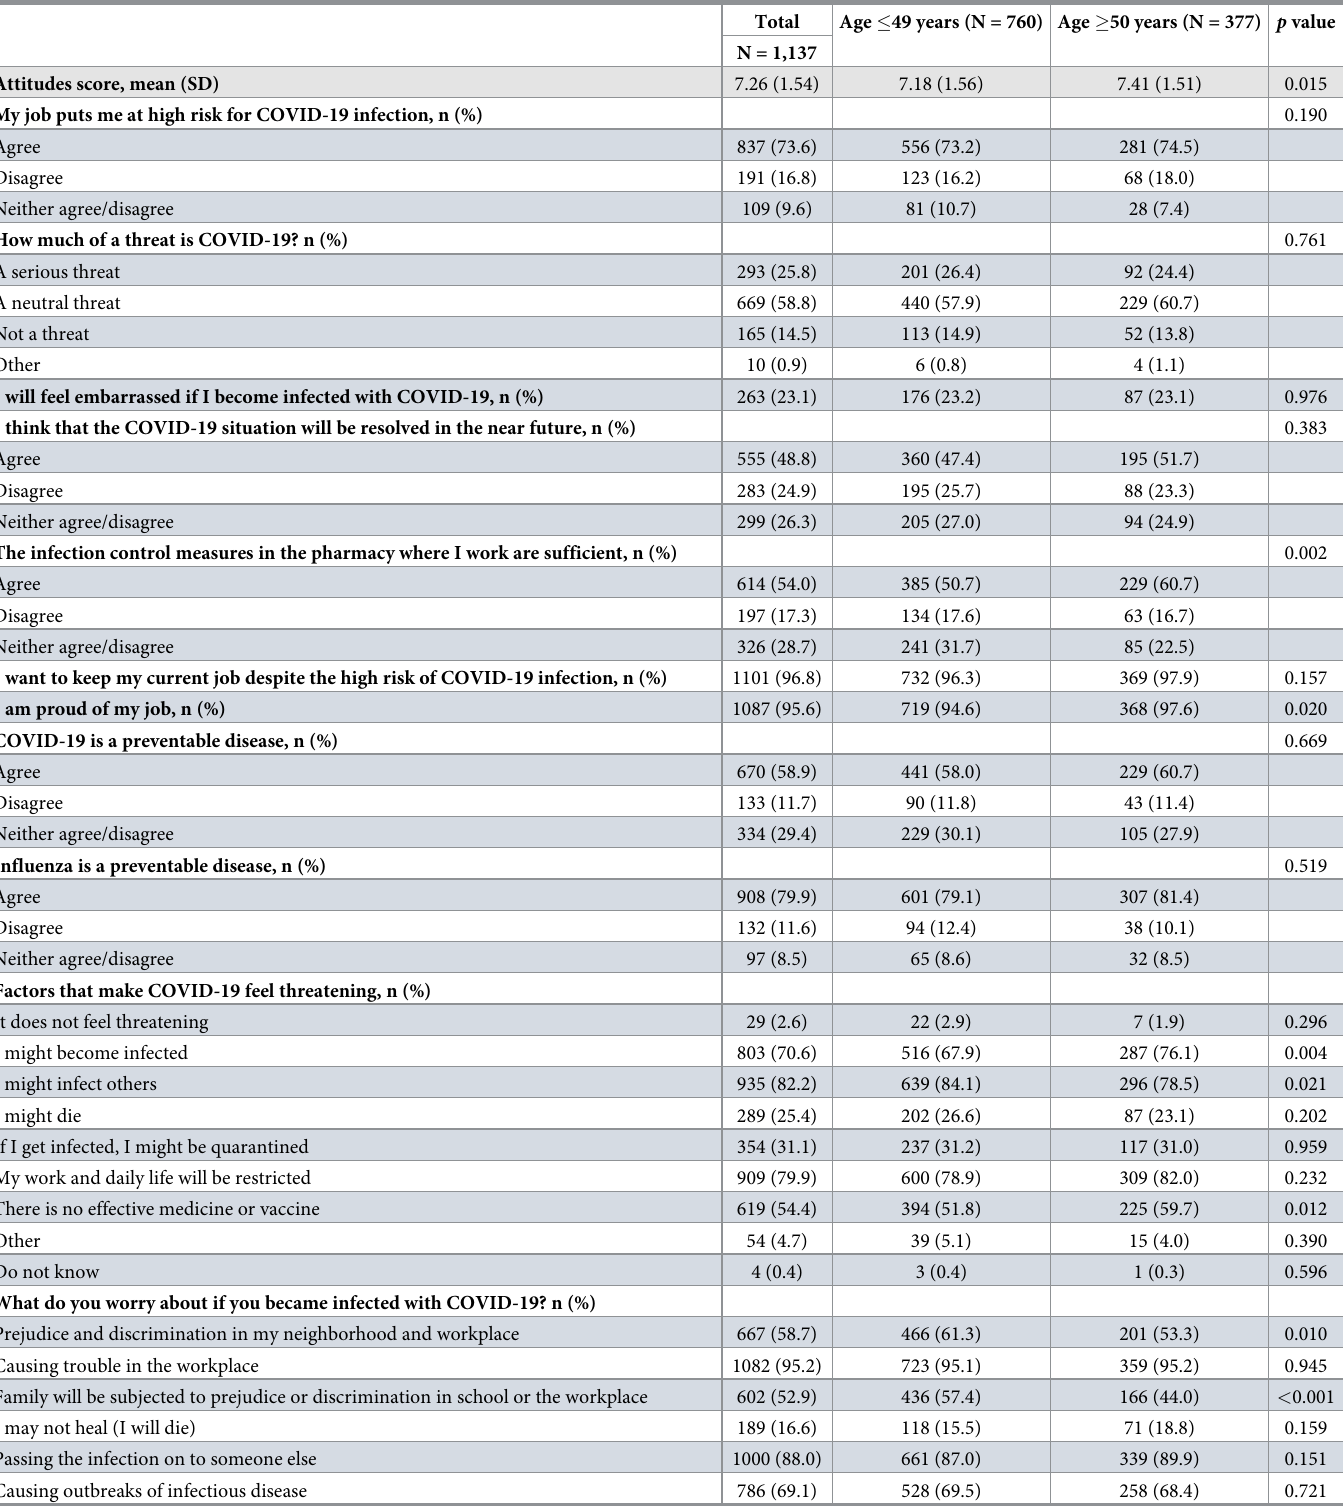
Table 3. Pharmacists’ responses regarding attitudes related to